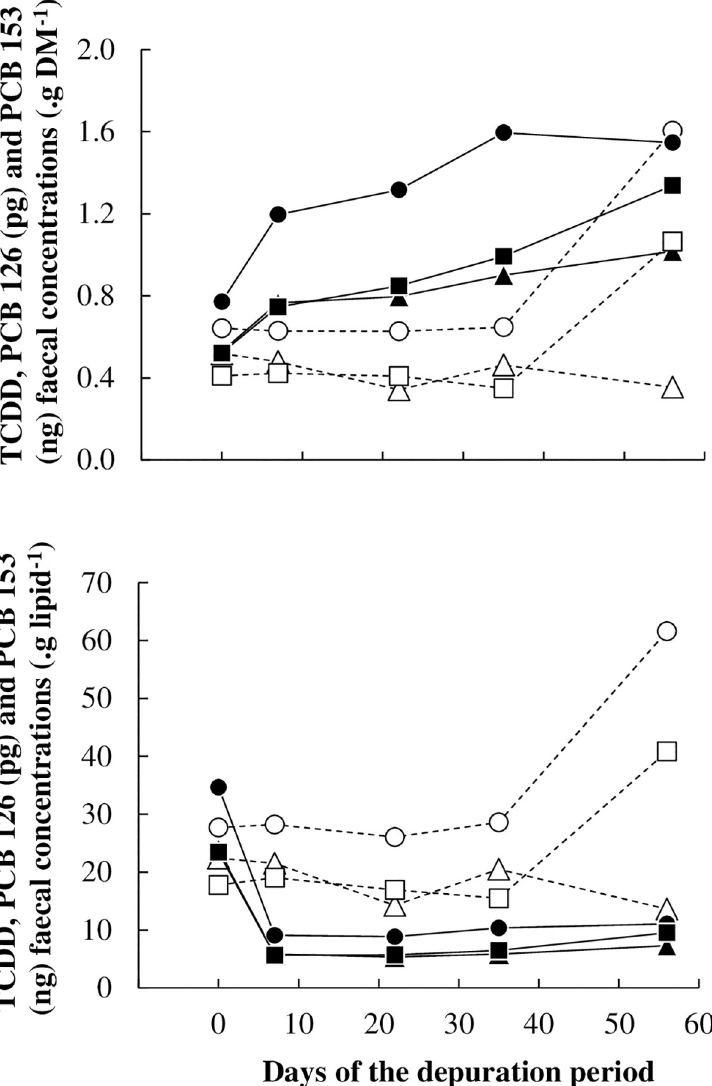
Fig 1. Time pattern kinetics of pollutants faecal concentrations based on dry matter (DM) or on lipids; with TCDD ( ▲ , Δ ), PCB 126 ( ● , � ) and PCB 153 ( ■ , □ ) in ewes receiving a control well-fed and non-supplemented treatment (CTL: Δ , � , □ ) or an underfed and mineral oil supplemented treatment (UFMO: ▲ , ● , ■ ). Each point represents individual results obtained from pools of faeces by treatment and by date.